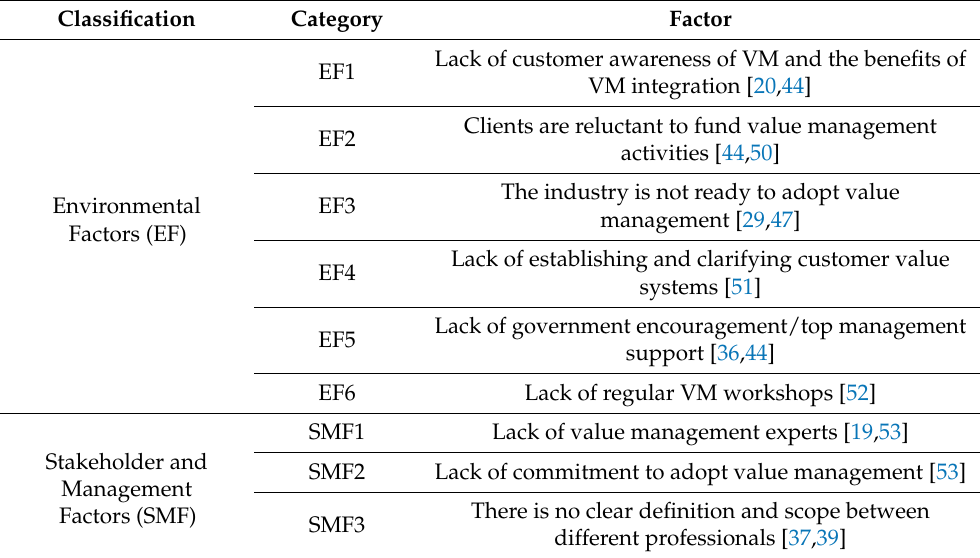
Table 1. Key obstacles for VM